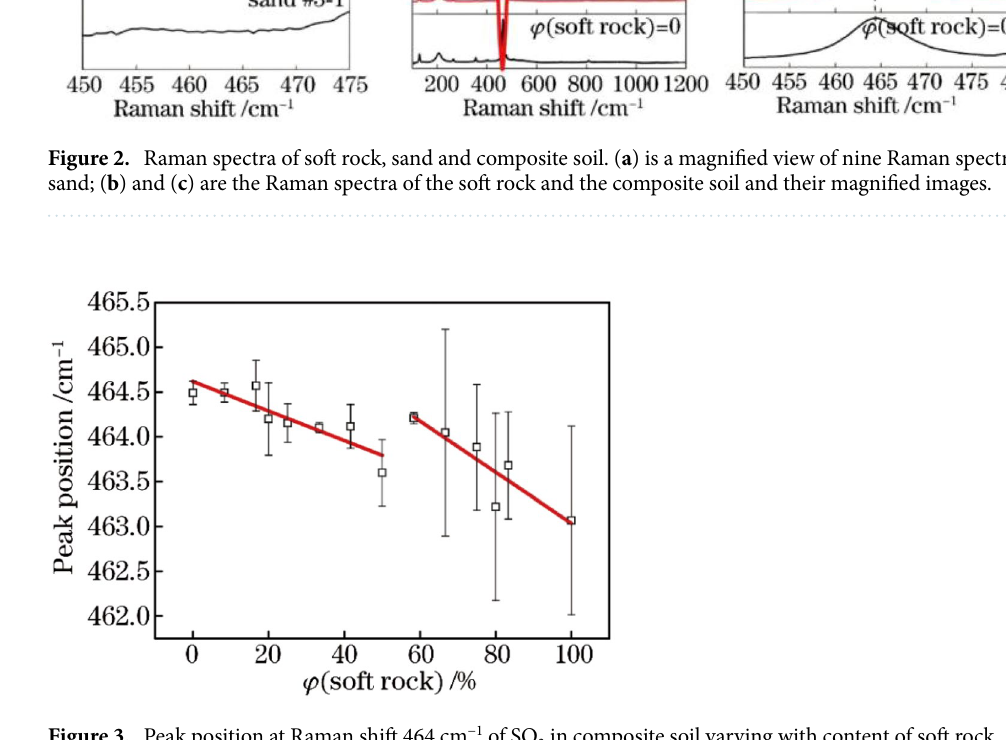
Figure 3. Peak position at Raman shift 464 cm −1 of SO 2 in composite soil varying with content of soft